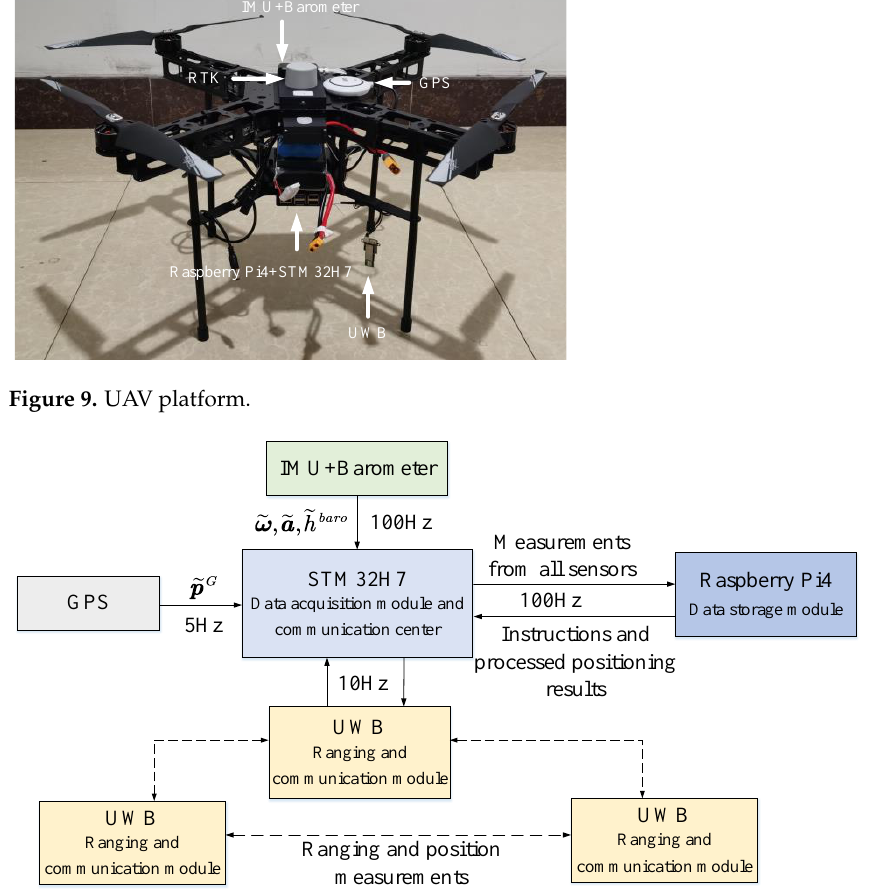
Figure 10. Navigation equipment configuration and signal flow.